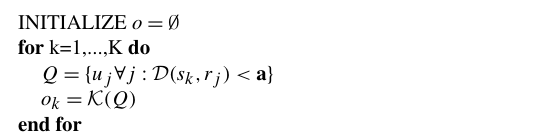
Algorithm 3 The ‘box’ collocation of an ungridded dataset onto a sampling set of coordinates s k of K points. By def- inition the output o is defined on the same spatio-temporal sampling as s . The distance metrics are defined for each D coordinate and compared with the user defined maximum a (the edge of the